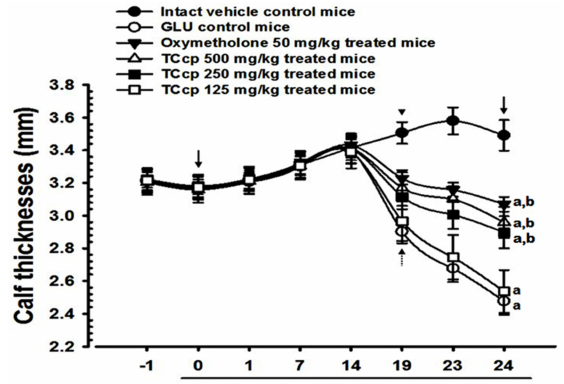
Figure 2. Changes in calf thickness in GLU-induced muscular atrophic mice. Values are expressed means ± S.D. of eight mice. Dot arrows show significant decreases in calf thickness in GLU con- trol mice after 5 days of initial DEXA treatment to sacrifice as compared with the intact control. However, these decreases in calf thicknesses were significantly and dose-dependently inhibited by oxymetholone, TCcp 500 and 250 mg/kg treatments (arrowhead). Day-1 means 1 day before start of the test material administration and day-24 means at sacrifice. Day 0 means at start of test material administration (2 weeks before initial DEXA treatment). All animals were overnight fasted before first test material administration and sacrifice (arrows). TCcp = tart cherry concentrated powder. GLU = glucocorticoid. DEXA = dexamethasone. a p < 0.01 as compared with intact control by LSD test. b p < 0.01 as compared with GLU control by LSD test.